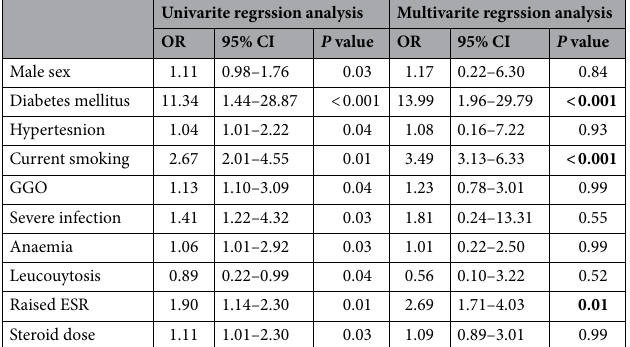
Table 5. Predictors of mucormycosis among patients with COVID-19 infection. COVID-19: coronavirus disease 2019; CI: confidence interval; ESR: erythrocyte sedimentation rate; OR: odd’s ratio; GGO: ground glass opacity. Significant values are given in bold. P value was significant if < 0.05.